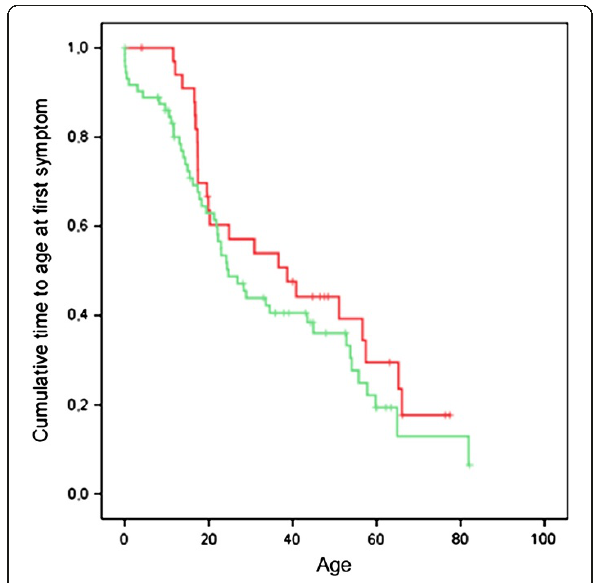
Figure 3 Age at first symptom. Time free from first symptom curve. Red graph: group A cases ( MYBPC3 IVS20-2A>G mutation carriers); green graph: group B cases (all other mutation carriers). Log rank test p = 0.226.